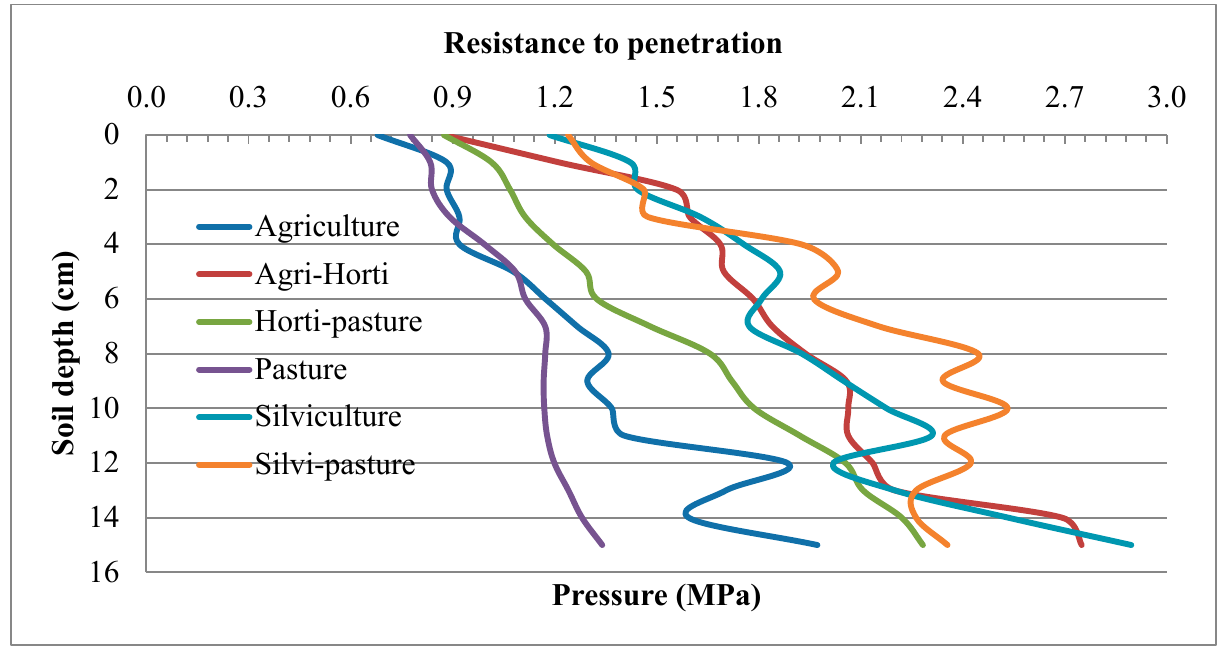
Figure 4. Resistance to penetration under different land use systems in semiarid arid climatic condition.